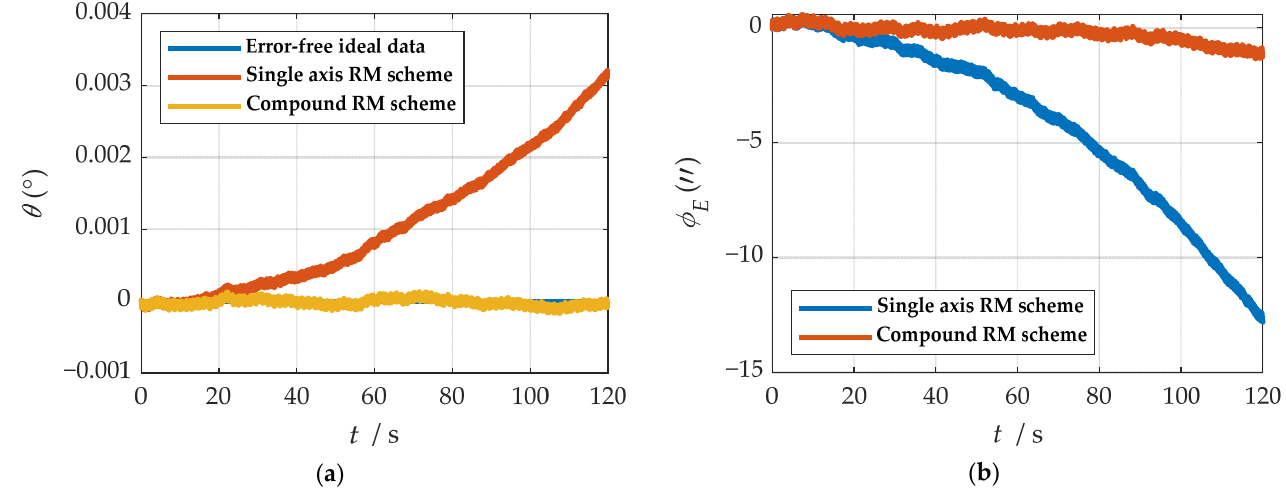
Figure 18. The navigation results comparison of the rotation scheme: ( a ) comparison of calculation results of yaw angle; ( b ) comparison of calculation results of east misalignment angle.